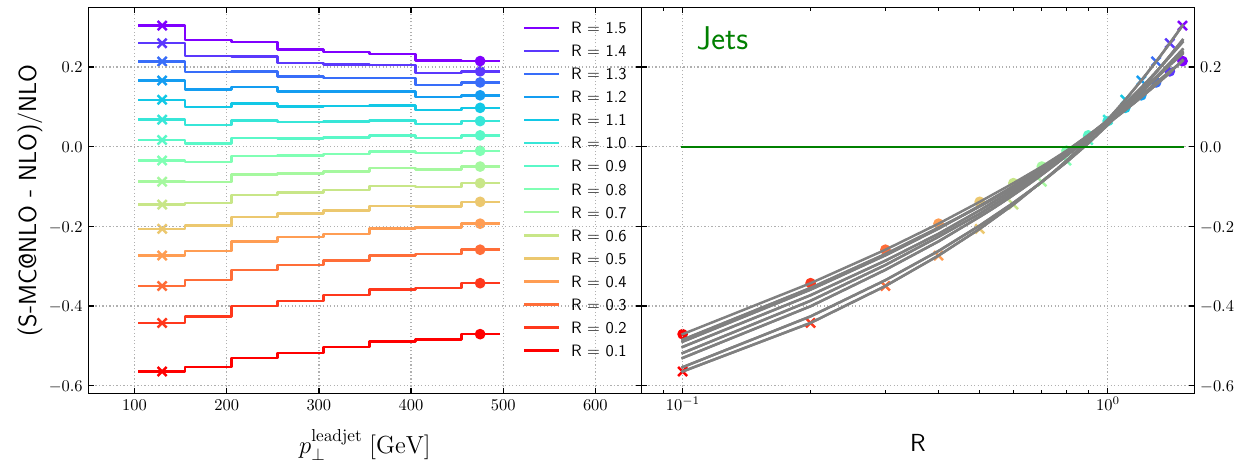
Fig. 17 Relative difference between the NLO-matched prediction and the fixed-order result as a function of the leading jet transverse momentum and the jet radius, for dijet production